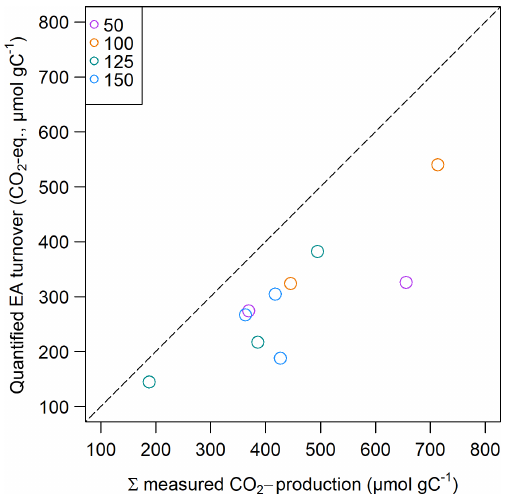
Figure 8. Calculated expected CO 2 production rate from prevalent EAs vs. measured potential CO 2 production rate in slurry incuba- tions. The dashed line shows the closed budget of expected and measured CO 2